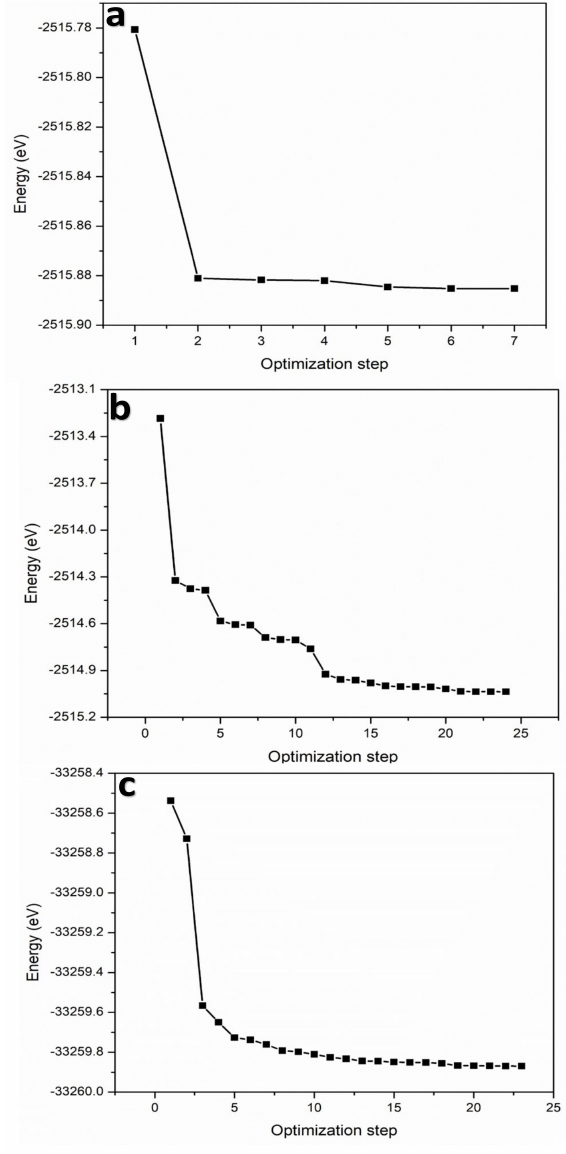
Figure 2. Atomistic energies for: ( a ) BiOCl, ( b ) BiOCl/Bi 2 O 3 , and ( c ) BiOCl/Ag 2